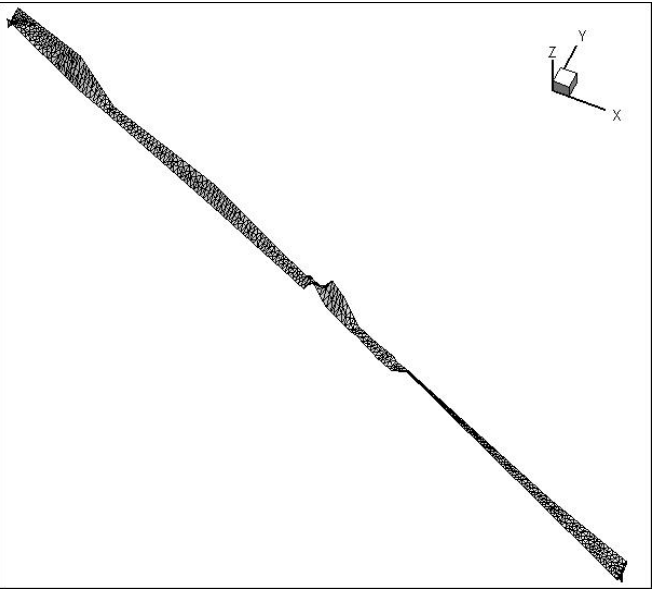
Fig. 4 Ajichai river layout in Iran (Tabriz) in specified river reach